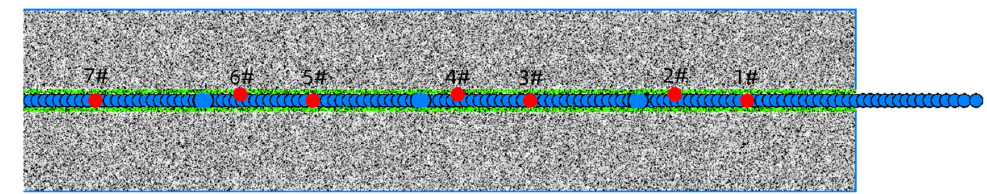
Figure 10. Model and measuring point of PFC simulation test.